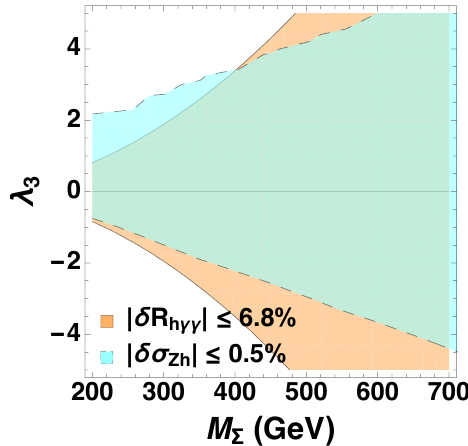
Figure 8. Contours in ( λ 3 , M Σ ) plane for | δσ Zh | ≤ 0 . 5% (cyan area outlined with dashed lines) and | δR 6 . 8% (orange area outlined with solid lines) in real triplet model. hγγ | ≤